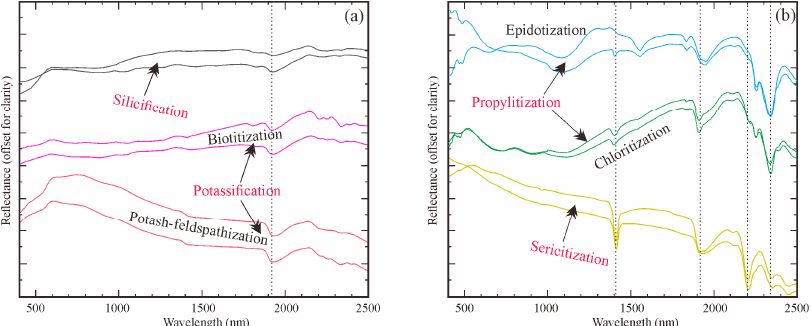
Figure 12. Sample spectra of alteration minerals measured from drill cores of the Pulang copper deposit. ( a ) Silification and potassification; ( b ) sericitization and propylitization. These sample spectra were only selected as representative of the alteration, and many drill core spectra have some subtle differences. Table 4. The number of labeled samples on the measured hyperspectral dataset. Class